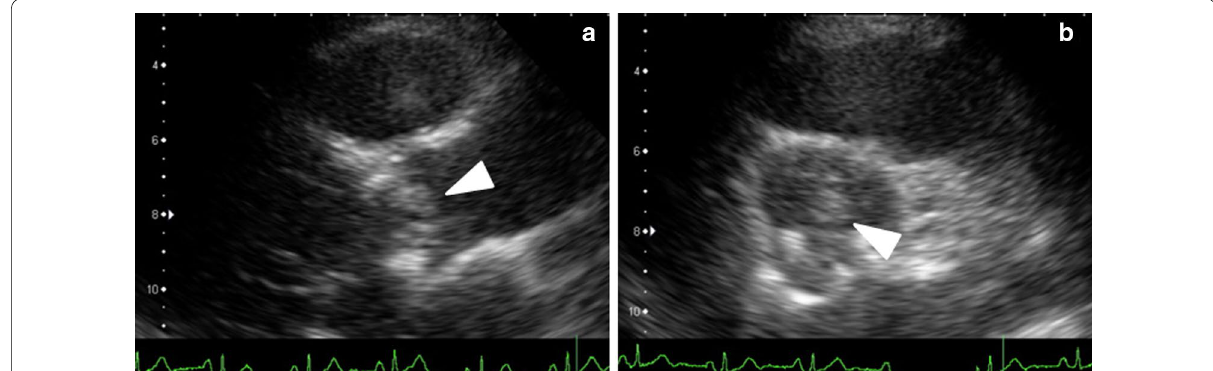
Fig. 1 a 2D echocardiogram. Apical long-axis view shows a large vegetation (arrow), measuring 16 mm